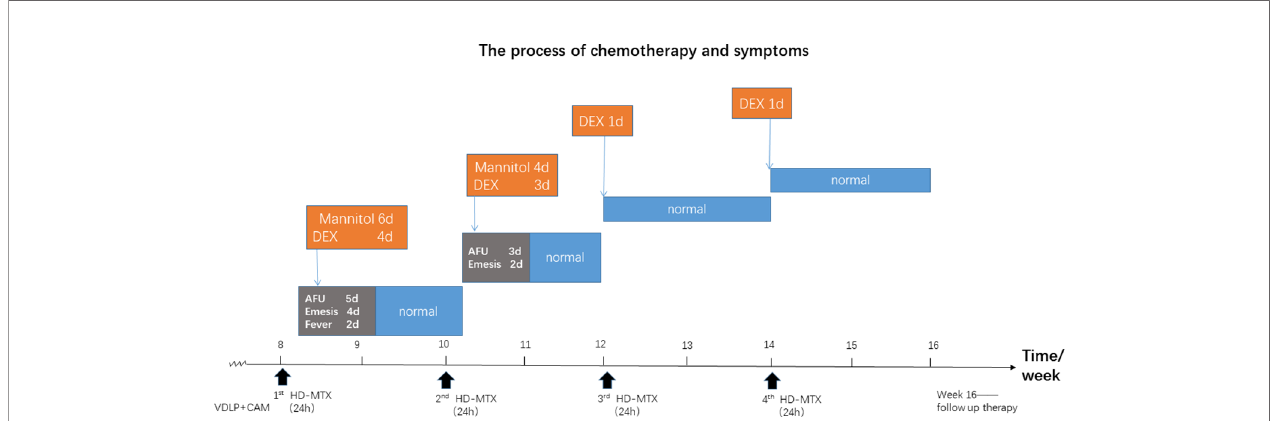
FIGURE 1 | The chemotherapy process of the patient based on the Chinese Children's Cancer Group ALL 2015 (CCCG-2015-ALL) protocol. The red rectangle represents the symptoms after high-dose maintenance(HD-MTX) induction; The orange describes dexamethasone(DEX) and the other drugs therapy when symptoms where noticed. The blue refers to performances after therapy. AFU is short for anterior fontanelle uplift. The red triangle indicates the start of HD- MTX